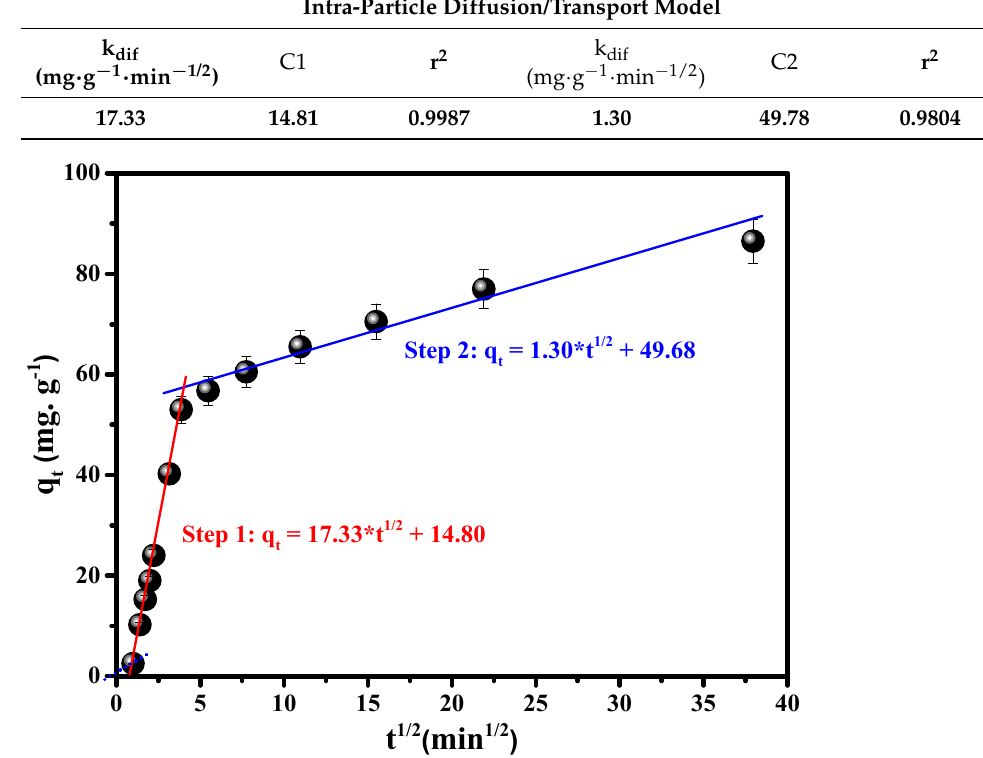
Figure 8. Intra-particle diffusion models (IPD) for Cu ions adsorption onto the prepared MgY 2 O 4 @g- C 3 N 4 nanomaterials.